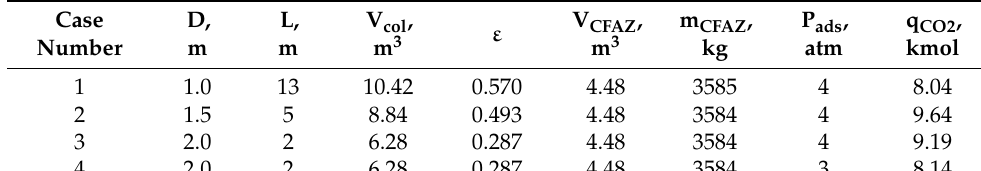
Table 4. Parameters for computation of pilot plant adsorption columns for CO 2 capture by TSA onto CFAZ.